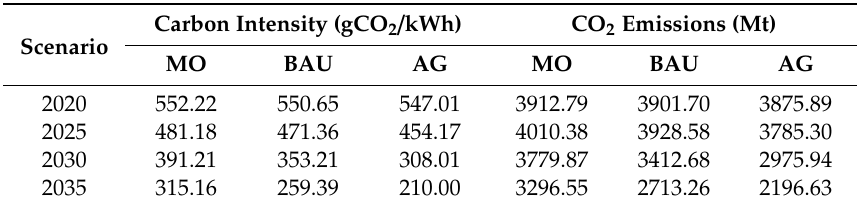
Table 14. Comparison of the CO 2 emissions in the electricity industry under the MO, BAU and AG electricity marketization scenarios.